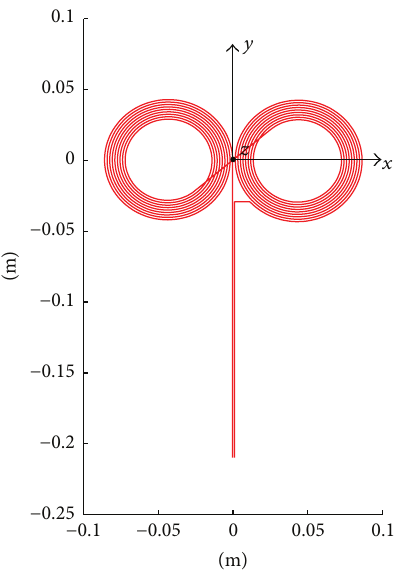
Figure 2: MATLAB model of the MAG-9925-00 coil with the associated Cartesian reference